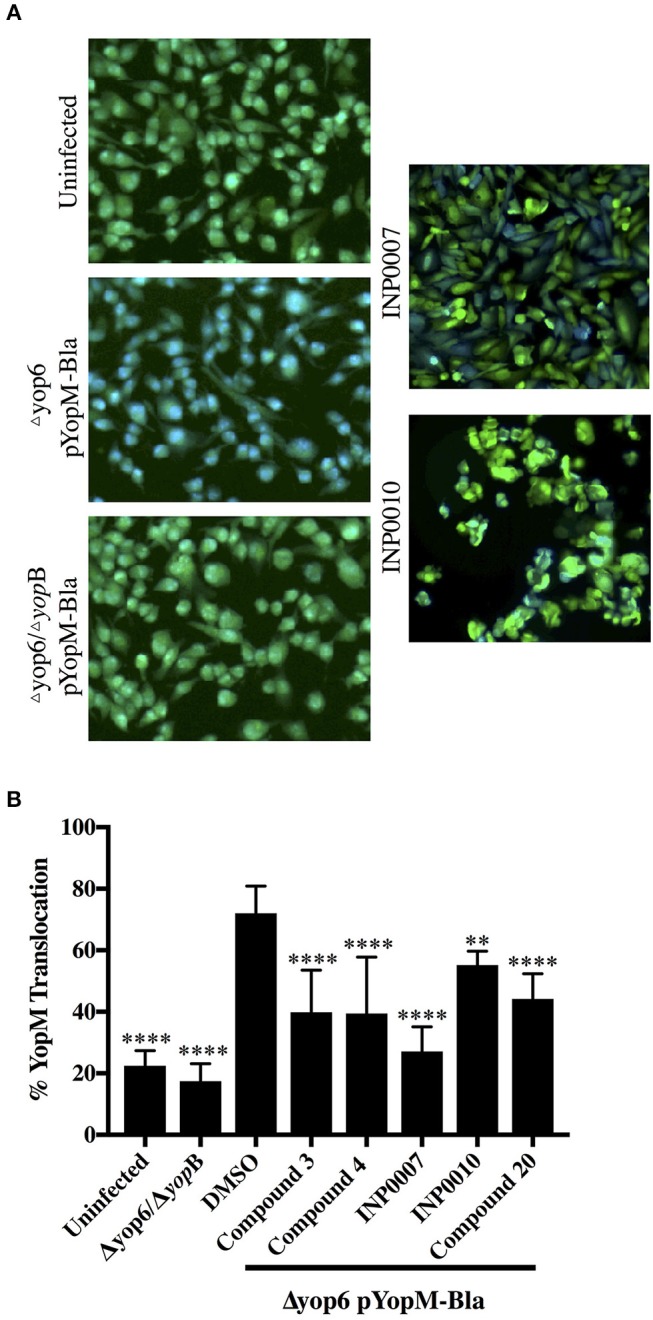
Translocation of YopM-Bla into mammalian cells in the presence of T3SS inhibitors. (A) Representative fluorescent micrographs of CCF2-AM loaded CHO K1 cells in the absence of bacteria (uninfected) or infected for 2 h with Y. pseudotuberculosis lacking YopHEMOJT but expressing the Yop reporter YopM-Bla (Δyop6 pYopM-Bla) at MOI 7 in the presence of 50 μM compound or equivalent volume of DMSO. A T3SS-defective mutant lacking the pore-forming protein YopB was used as a negative control (Δyop6/ΔyopB pYopM-Bla). (B) CCF2 green (uncleaved) and blue (cleaved) fluorescence was measured and the average from three biological replicates ± standard deviation is shown and statistical significance is represented relative to the DMSO control. ****P < 0.0001, **P < 0.007 (one way ANOVA with Dunnett's post-hoc test).